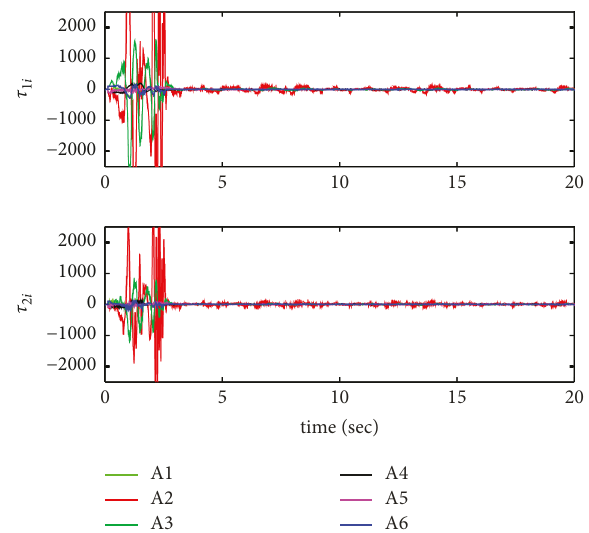
Figure 12: The control inputs τ